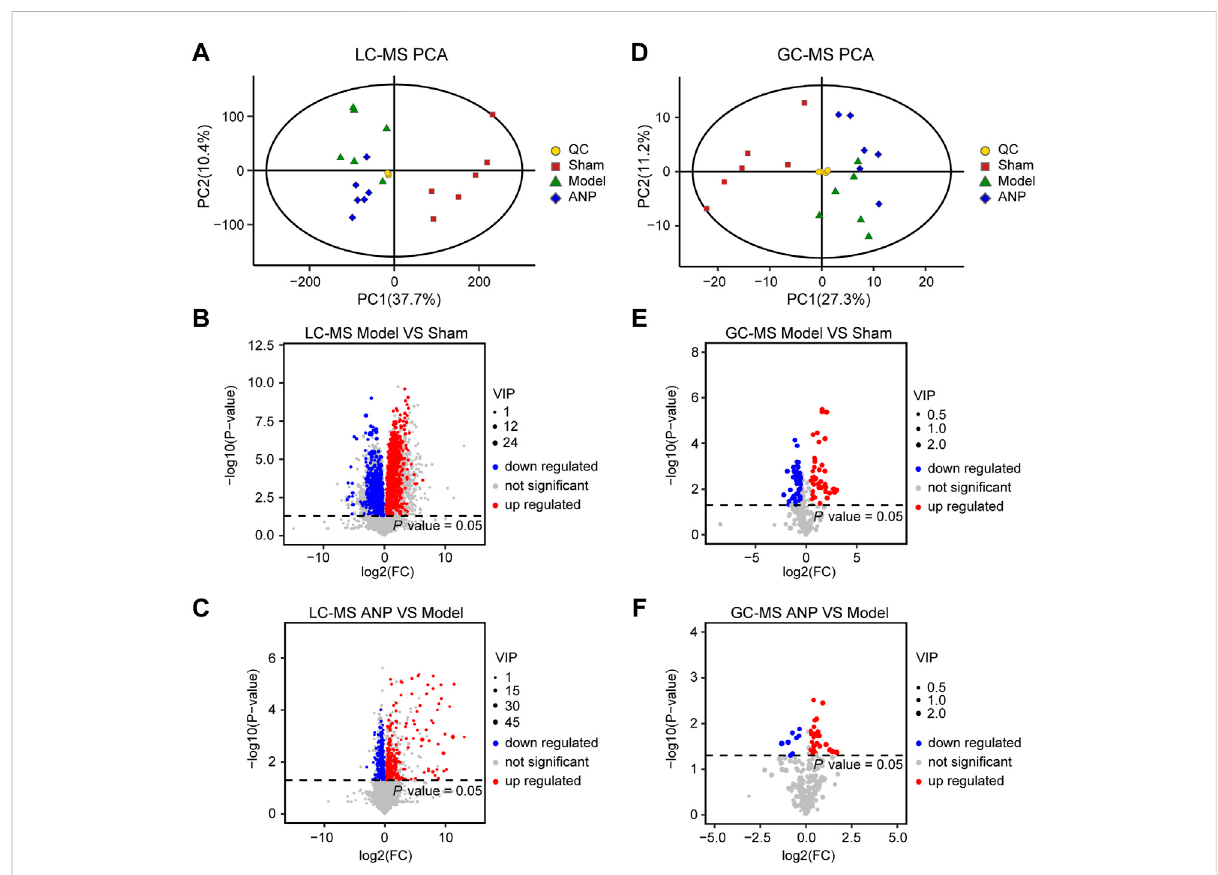
FIGURE 6 The multivariate data analysis from LC-MS and GC-MS data. (A) The PCA score plot of the LC-MS data. (B,C) The volcano plot for the differentiallyexpressed metabolites between themodelandtheshamgroups (B) aswellas between theANPandthemodelgroups (C) basedonthe LC-MS data. (D) The PCA score plot of the GC-MS data. (E,F) The volcano plot for differentially expressed metabolites between the model and the sham groups (E) as well as between the ANP and the model groups (F) based on the GC-MS